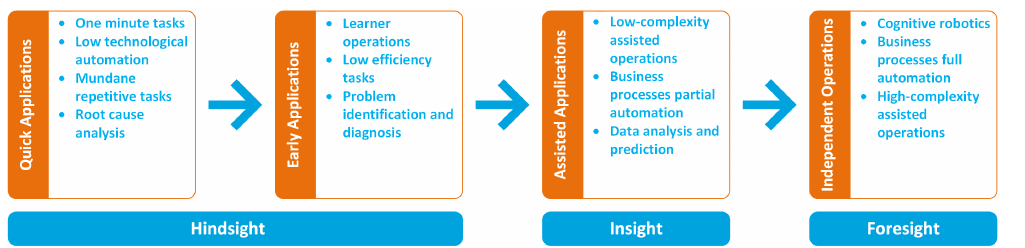
Figure 1. Machine learning (ML) technology adoption process (adapted from